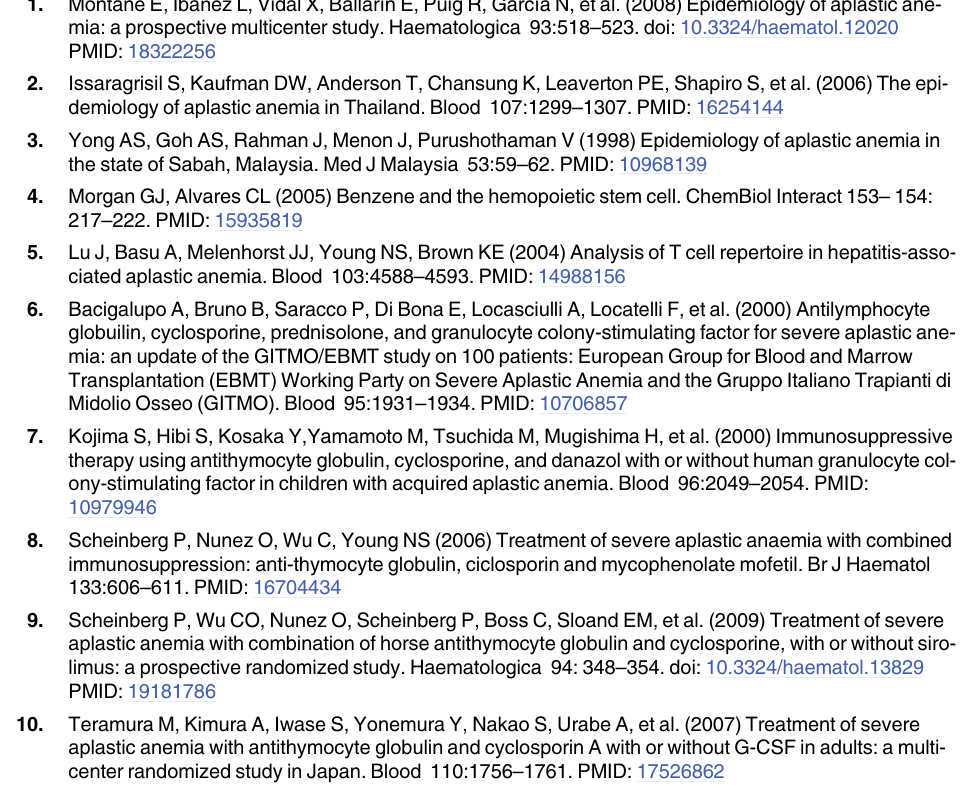
S1 Table. Individual characteristics of 43 patients who were at risk of relapse. Characteris- tics of patients who responded to